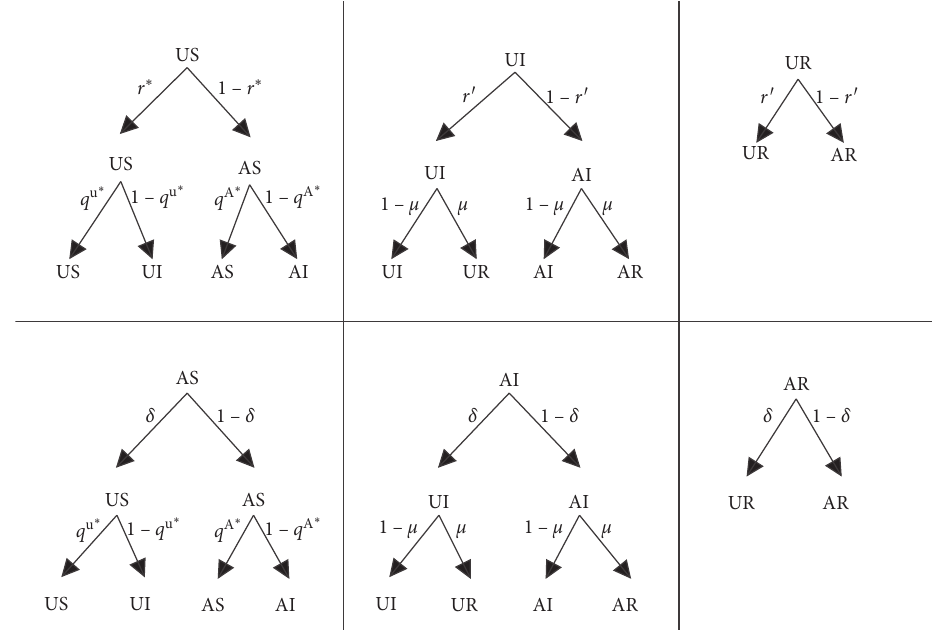
Figure 4: Transition probability trees for six possible states.